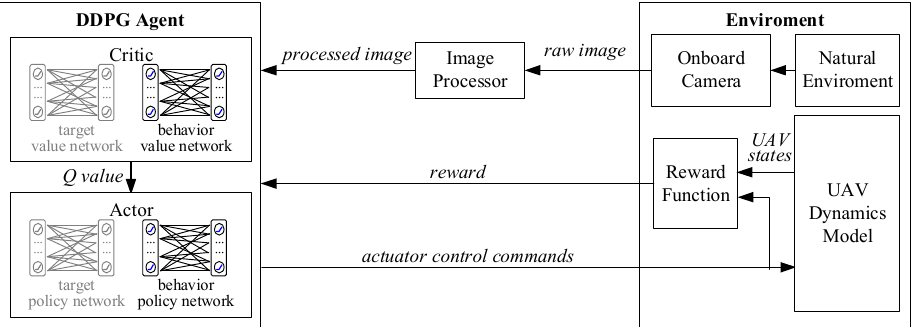
Figure 3. The image-based RL framework for a UAV control